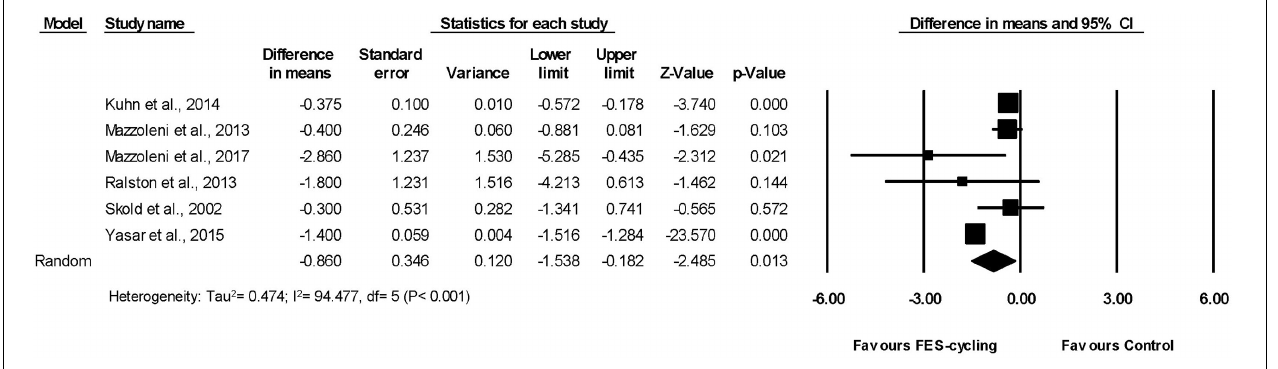
FIGURE 2 | A forest plot of spasticity after functional electrical stimulation (FES)-cycling training.